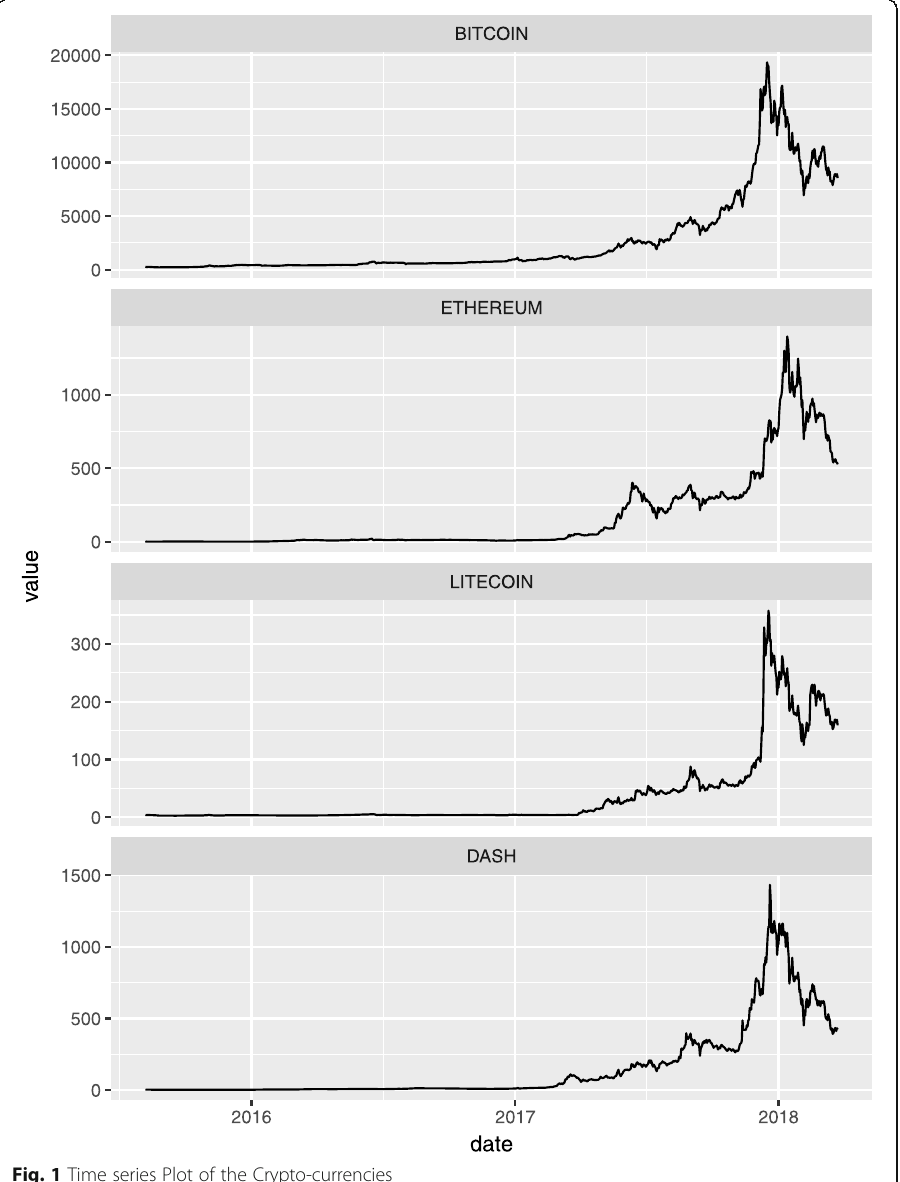
Fig. 1 Time series Plot of the